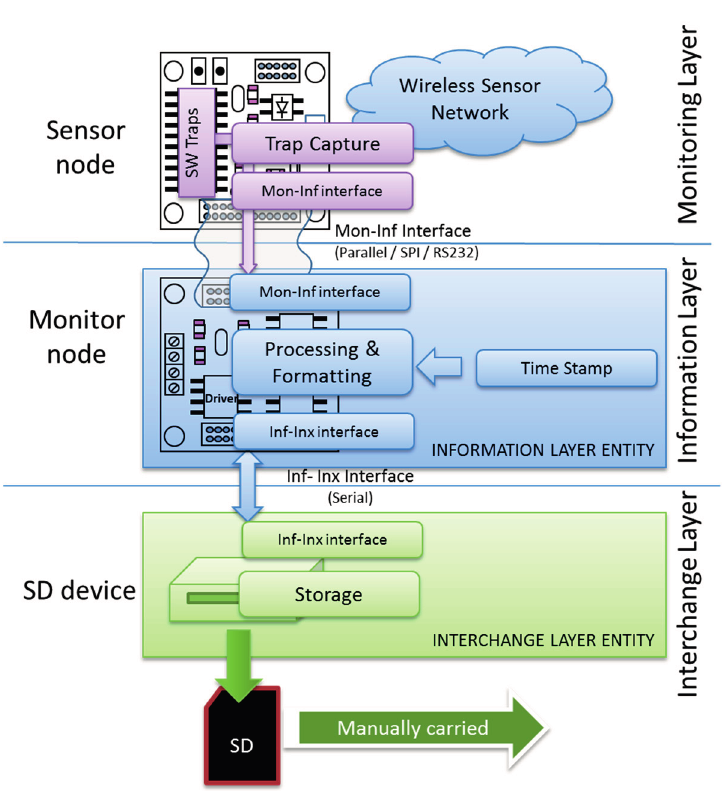
Figure 2. Implementation of the proposed hybrid